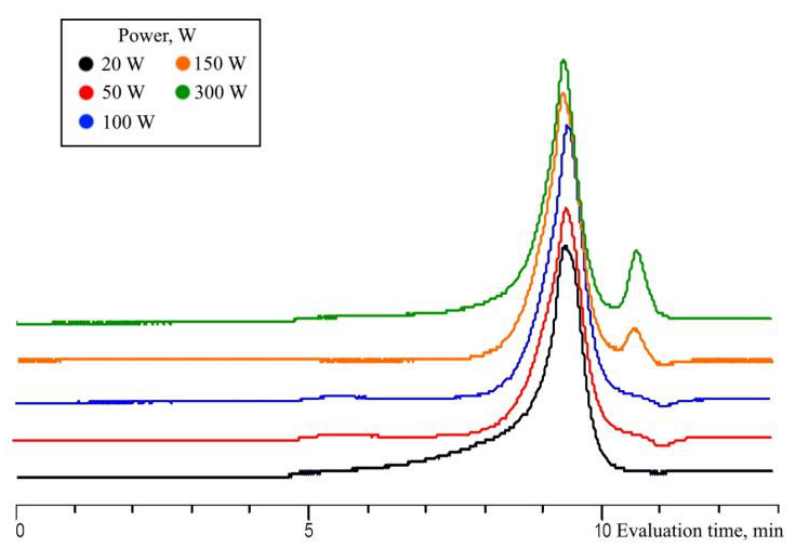
Figure 14. GPC curves of the oligomeric fraction obtained by MWHP of MTMS at different radiation powers and an MTMS/Н 2 О molar ratio of 1/1 .5, at 30 °C for 5 min (Samples 7, 18 – 21, Table 1).